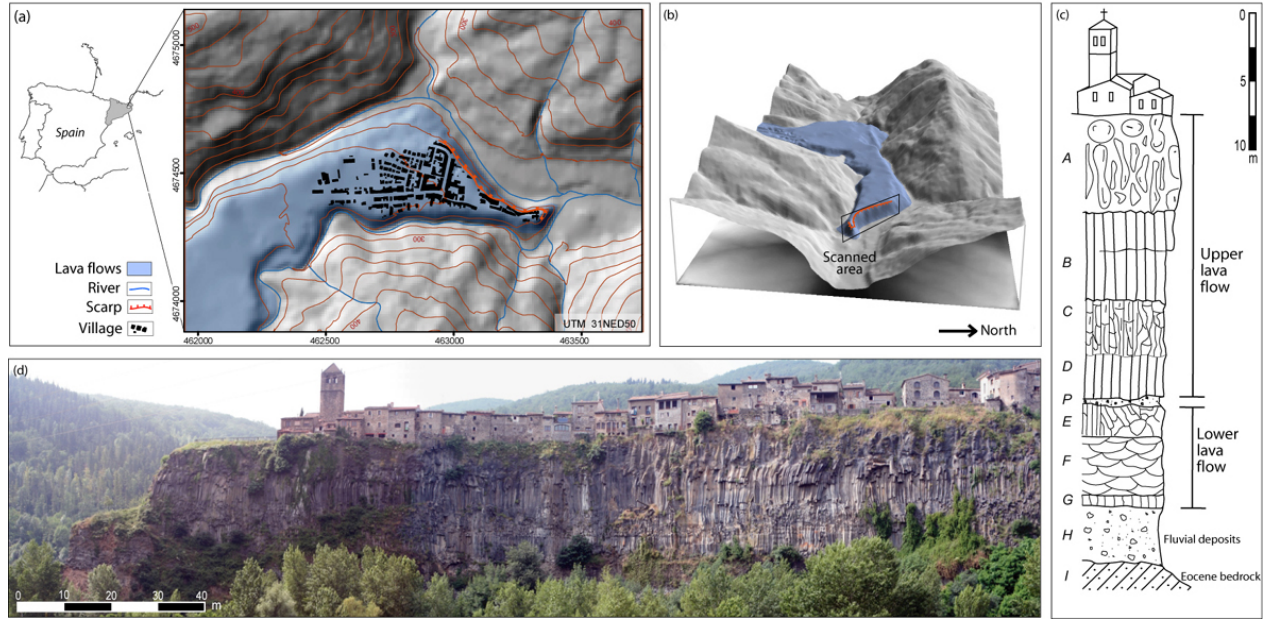
Fig. 1. (a) Location of the village and the basaltic formation at Castellfollit de la Roca (Garrotxa Volcanic Field, NE Spain). (b) Perspective view with indication of the scanned rockface. (c) Synthetic stratigraphic sequence modified from Pall´ı and Trilla (1976). Thickness ∼ 45m. See Table 1 for a description of the geological levels (from A to I). (d) Panoramic view of the north face of the basaltic formation at Castellfollit de la Roca. Houses located on the edge of the cliff are